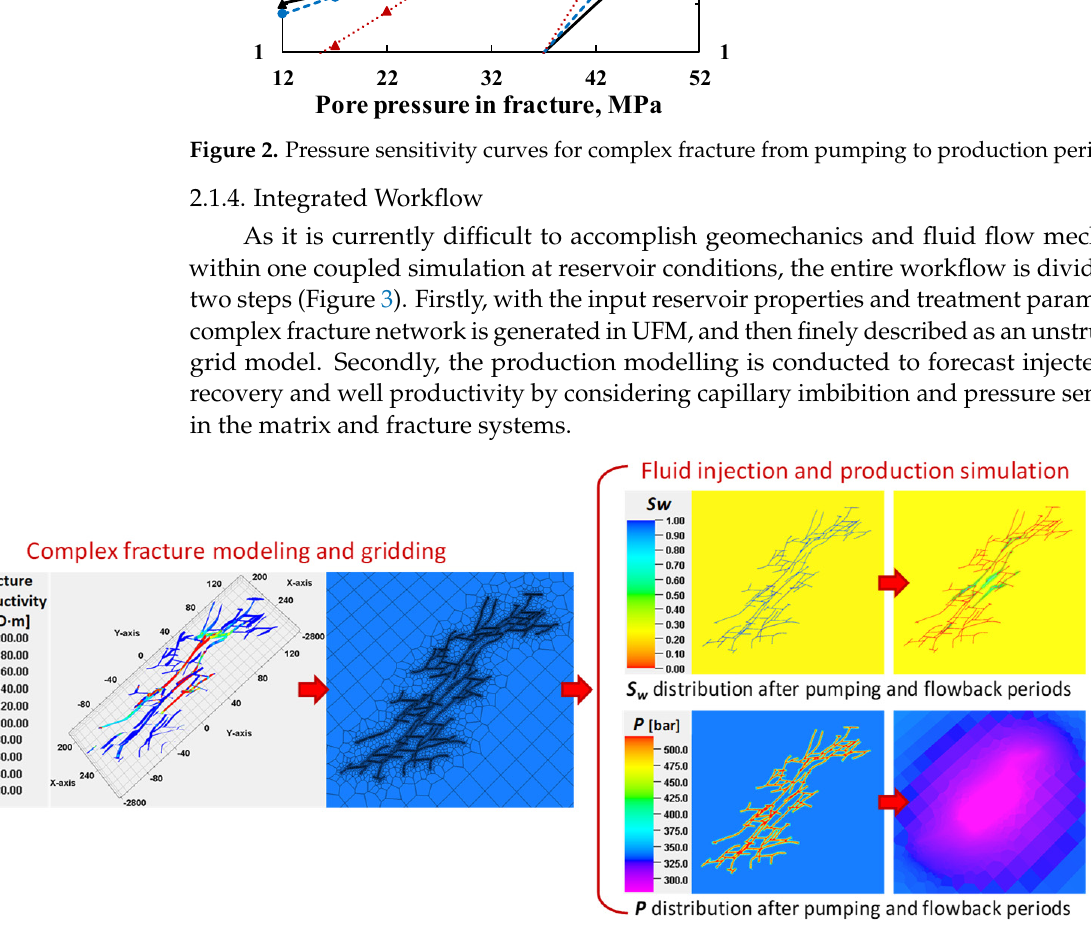
Figure 3. Numerical simulation workflow based on complex fracture modelling.